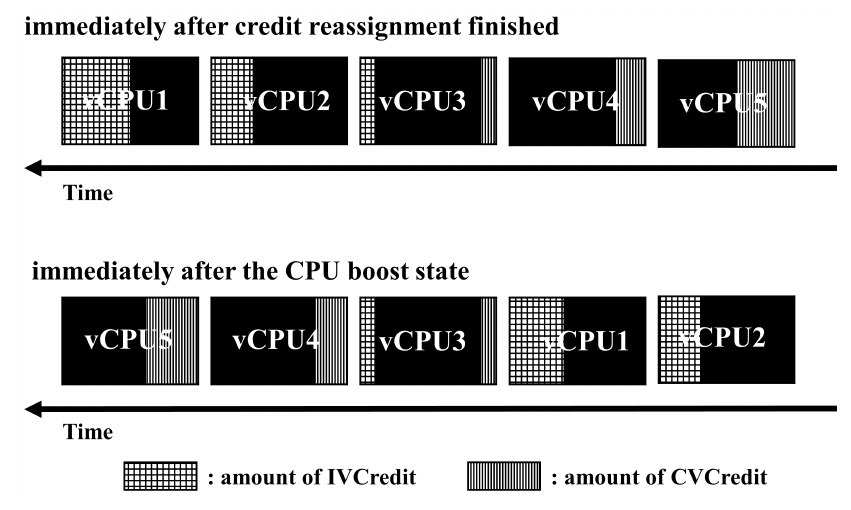
Figure 5. ISACS credit concealing method. IVCredit, I/O virtual credit; CVCredit, CPU virtual credit.